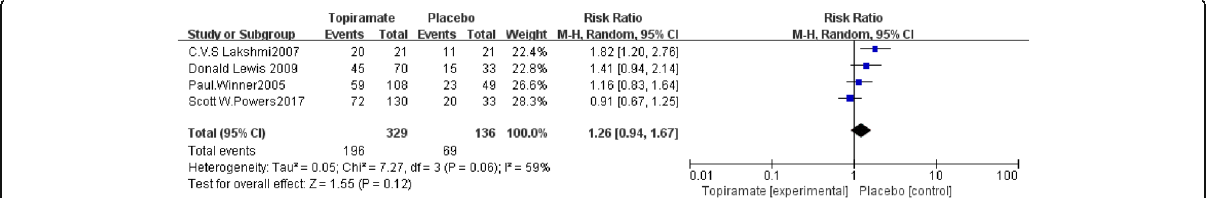
Fig. 3 Forest plot of comparison: ≥ 50% Relative reduction in headache frequency of topiramate versus placebo